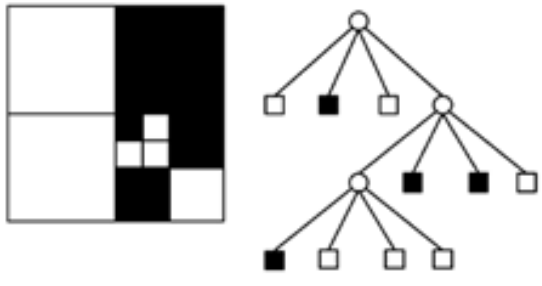
Figure 10. Illustration of quadtree image